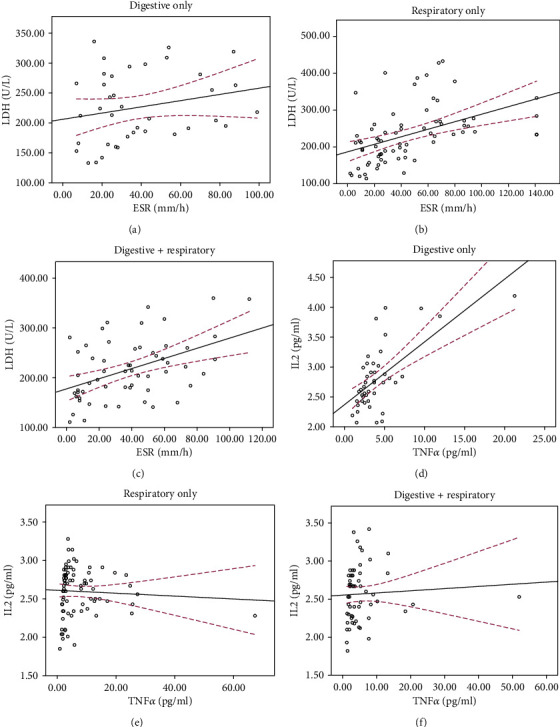
Correlation analysis of IL-2 levels and TNF-α levels (a–c), LDH levels and ESR levels (d–f) in COVID-19 patients with different symptoms. The black line is a linear fitting line and the red dotted line represents the confidence interval of the average.